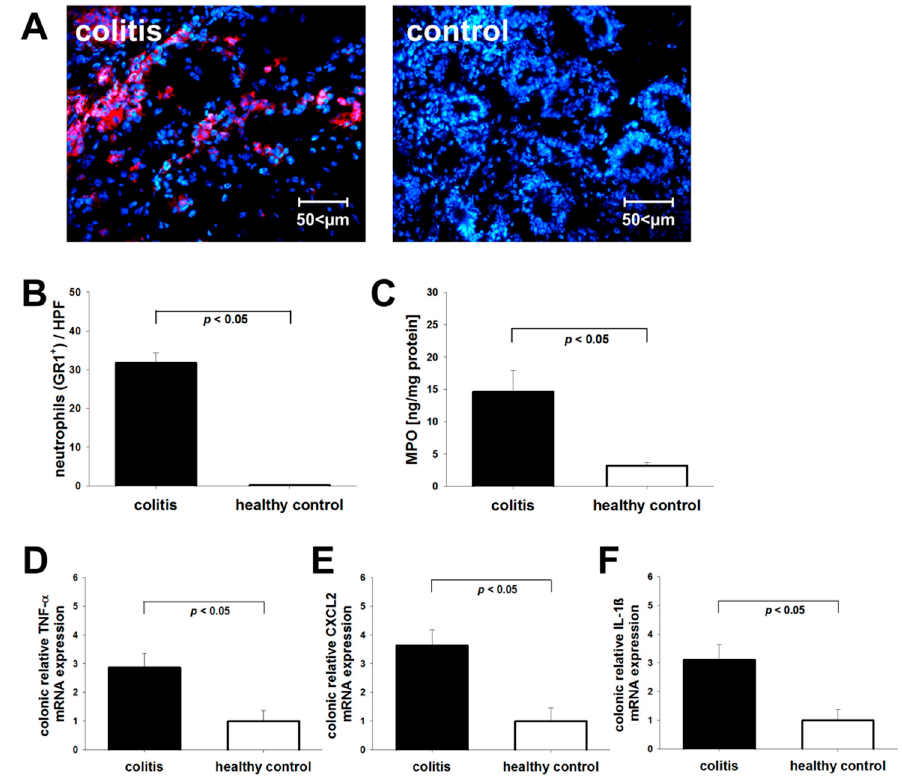
Figure 2. Assessment of intestinal neutrophil infiltrate and pro-inflammatory cytokines. Infiltration of neutrophils into the intestinal wall was determined post-mortem in DSS-colitic mice and healthy controls. Shown are data from one experiment (n = 5 per group). Results were confirmed in two experiments. ( A ) Immunofluorescent visualization of neutrophil infiltration in the mucosa. Shown are representative images of anti-Gr-1 staining in colitic and control mice. ( B ) Bar graph: Cell count / high power field (HPF). ( C ) Confirmatory measurements of myeloperoxidase (MPO) concentration in colon tissue of colitic and non-colitic control mice. mRNA levels of pro-inflammatory cytokines TNF- α ( D ), CXCL2, ( E ) and IL-1 β ( F ). mRNA was isolated from the colon of mice for the RTq-PCR analysis. The cytokine mRNA expression level in the healthy control group was set as 100%, and mRNA expression levels in colitic mice were compared with the control group.